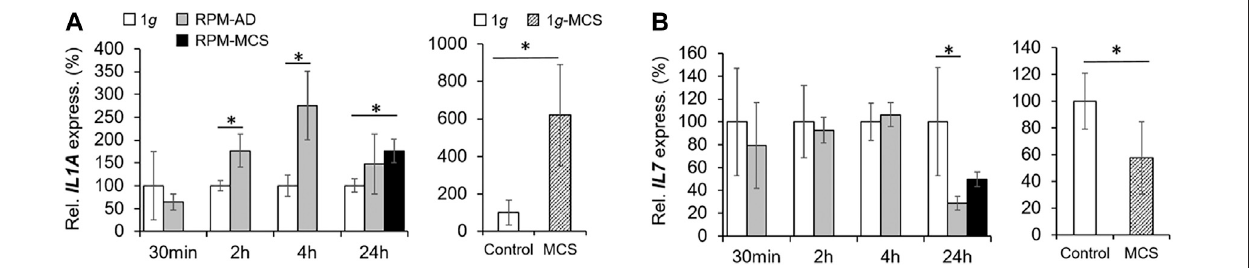
FIGURE 6 | Anti-in fl ammatory cytokines: Gene expression of (A) IL1A and (B) I L17 of PC-3 cells exposed to the RPM for 30 min, 2, 4 and 24 h and 1 g -MCS after 24 h. n = 5; * p < 0.05 vs. 1 g .